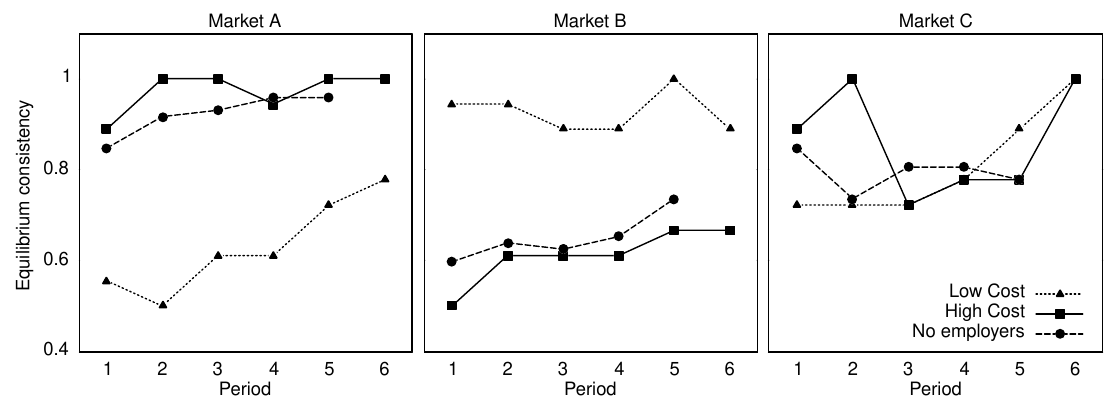
Figure 5. Equilibrium consistency of workers’ revelation decisions over